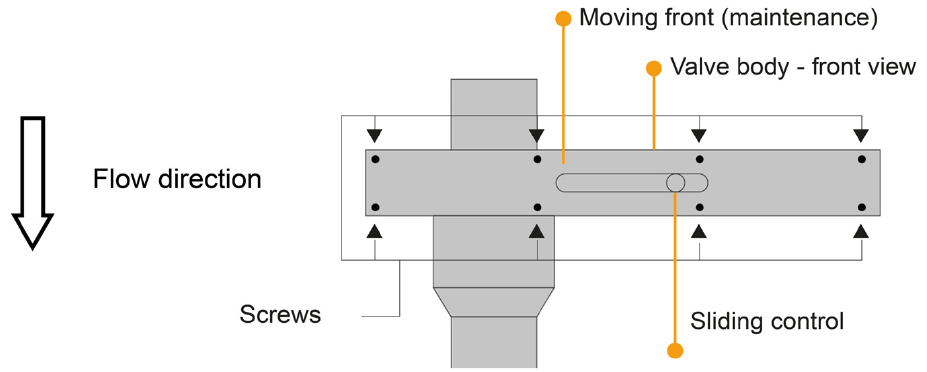
Figure 6. Valve Figure 6. Valve components.